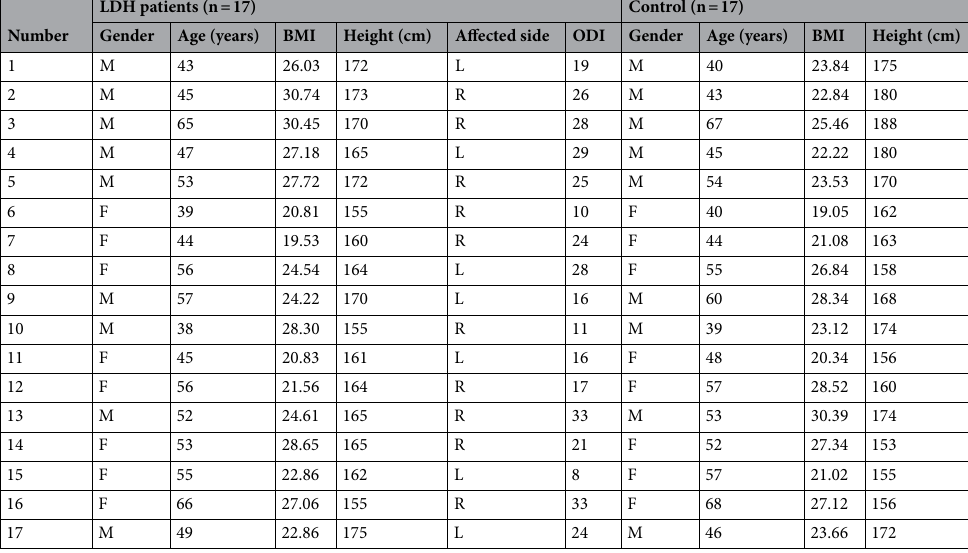
Table 1. Descriptive characteristics of subjects. LDH lumbar disc herniation, n number of subjects, BMI body mass index, ODI oswestry disability index.